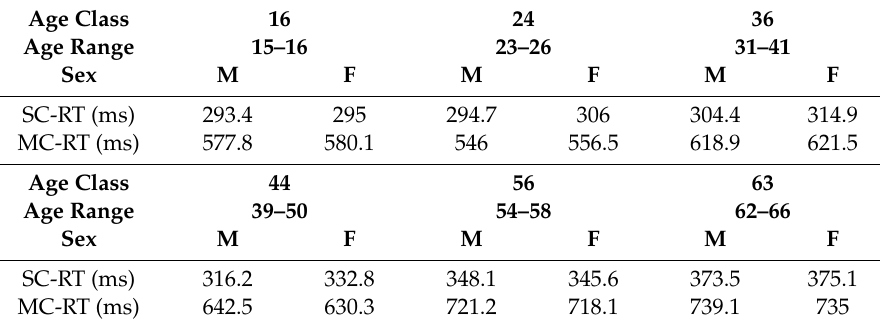
Table 1. Mean single-choice reaction time (SC-RT) and mean multiple-choice reaction time (MC-RT) for different age classes and sex (M for male, F for female). Source: Authors’ elaboration of data from [54].